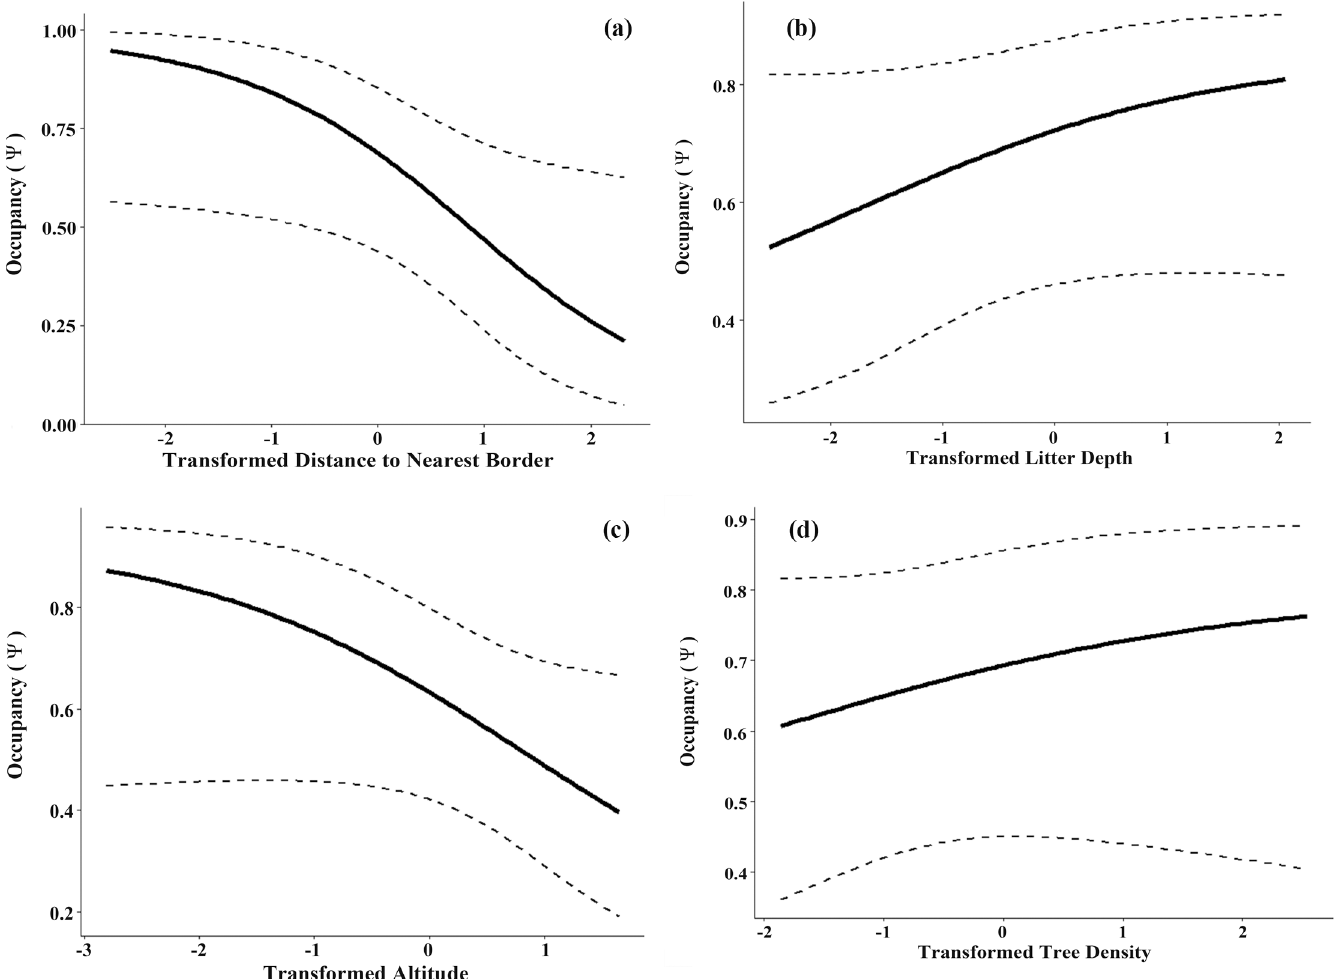
Fig 5. Model-averaged predicted occupancy ( Ψ ) in relation to (a) The distance from the nearest border (95% CI = 0.194. -1.040), (b) Litter depth (95% CI = 0.454, -0.146), (c) Altitude (95% CI = 0.179, -0.716) and (d) Tree density (95% CI = 0.304, -0.121). Predictor variables were log transformed.